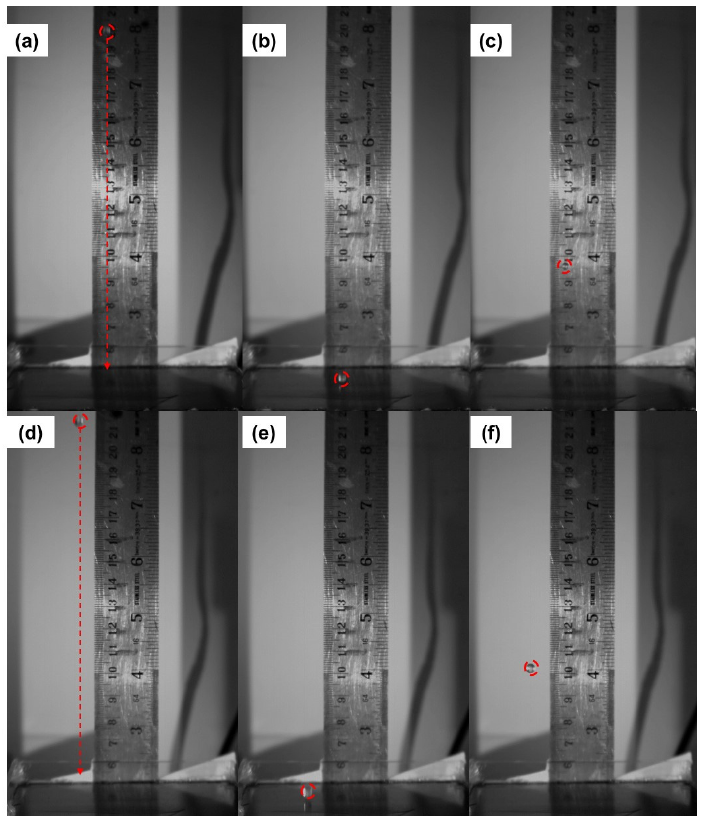
Figure 4. Various stages of glass ball impacting on rubber block ( a – c ) 3 mm glass ball ( d – f ) 4 mm glass ball. Table 2. Average value of coe ffi cient of restitution for 2, 3 and 4 mm sized glass balls with various block combinations at di ff erent impact